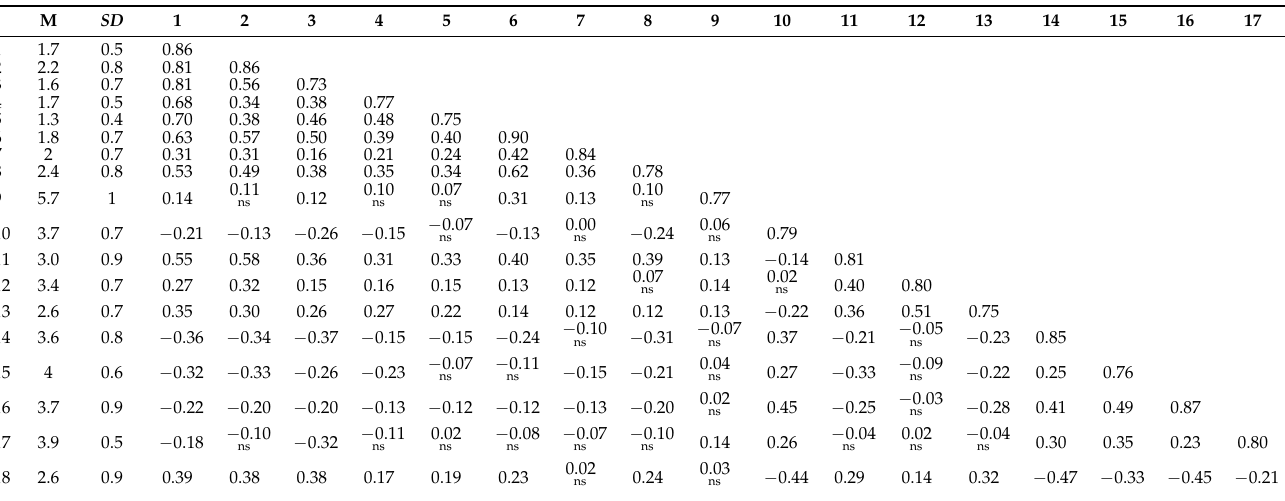
Table 1. Mean (M), standard deviation (SD), correlation (two-tailed Pearson’s r), and Cronbach’s alpha for the study variables.